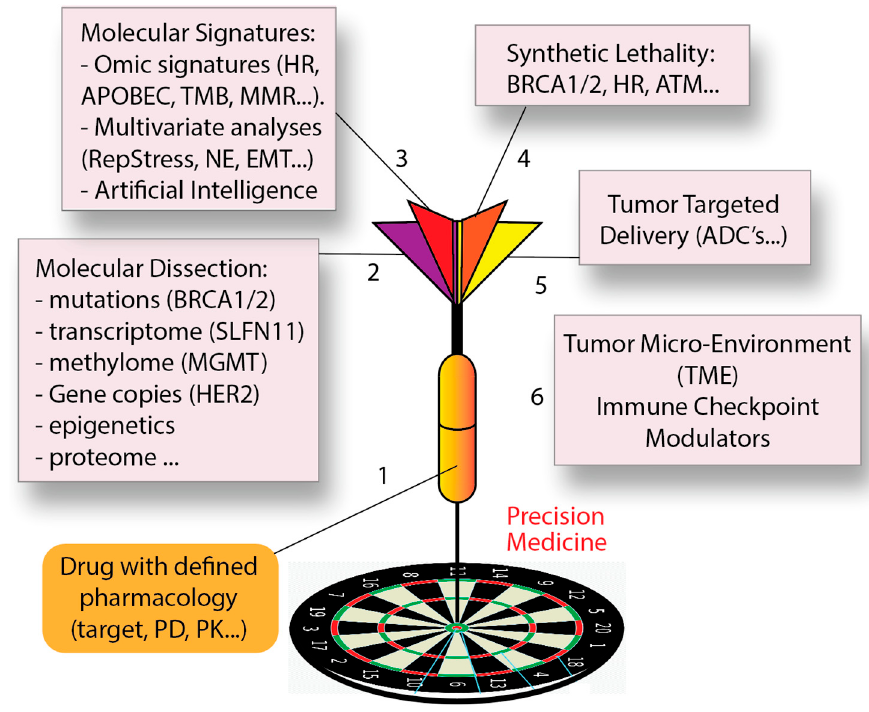
Figure 2. Precision medicine in the context of DNA-targeted therapies. Critical steps are: ( 1 ) Defin- ing the molecular and clinical pharmacology of the drugs; ( 2 ) molecular dissection of tumors by multi-omics approaches; ( 3 ) identification of molecular signatures combining omic parameters; ( 4 ) determination of synthetic lethal interactions; ( 5 ) Targeted-delivery of drugs to cancer cells; and ( 6 ) adjuvant therapy by targeting the tumor microenvironment and immune checkpoints.